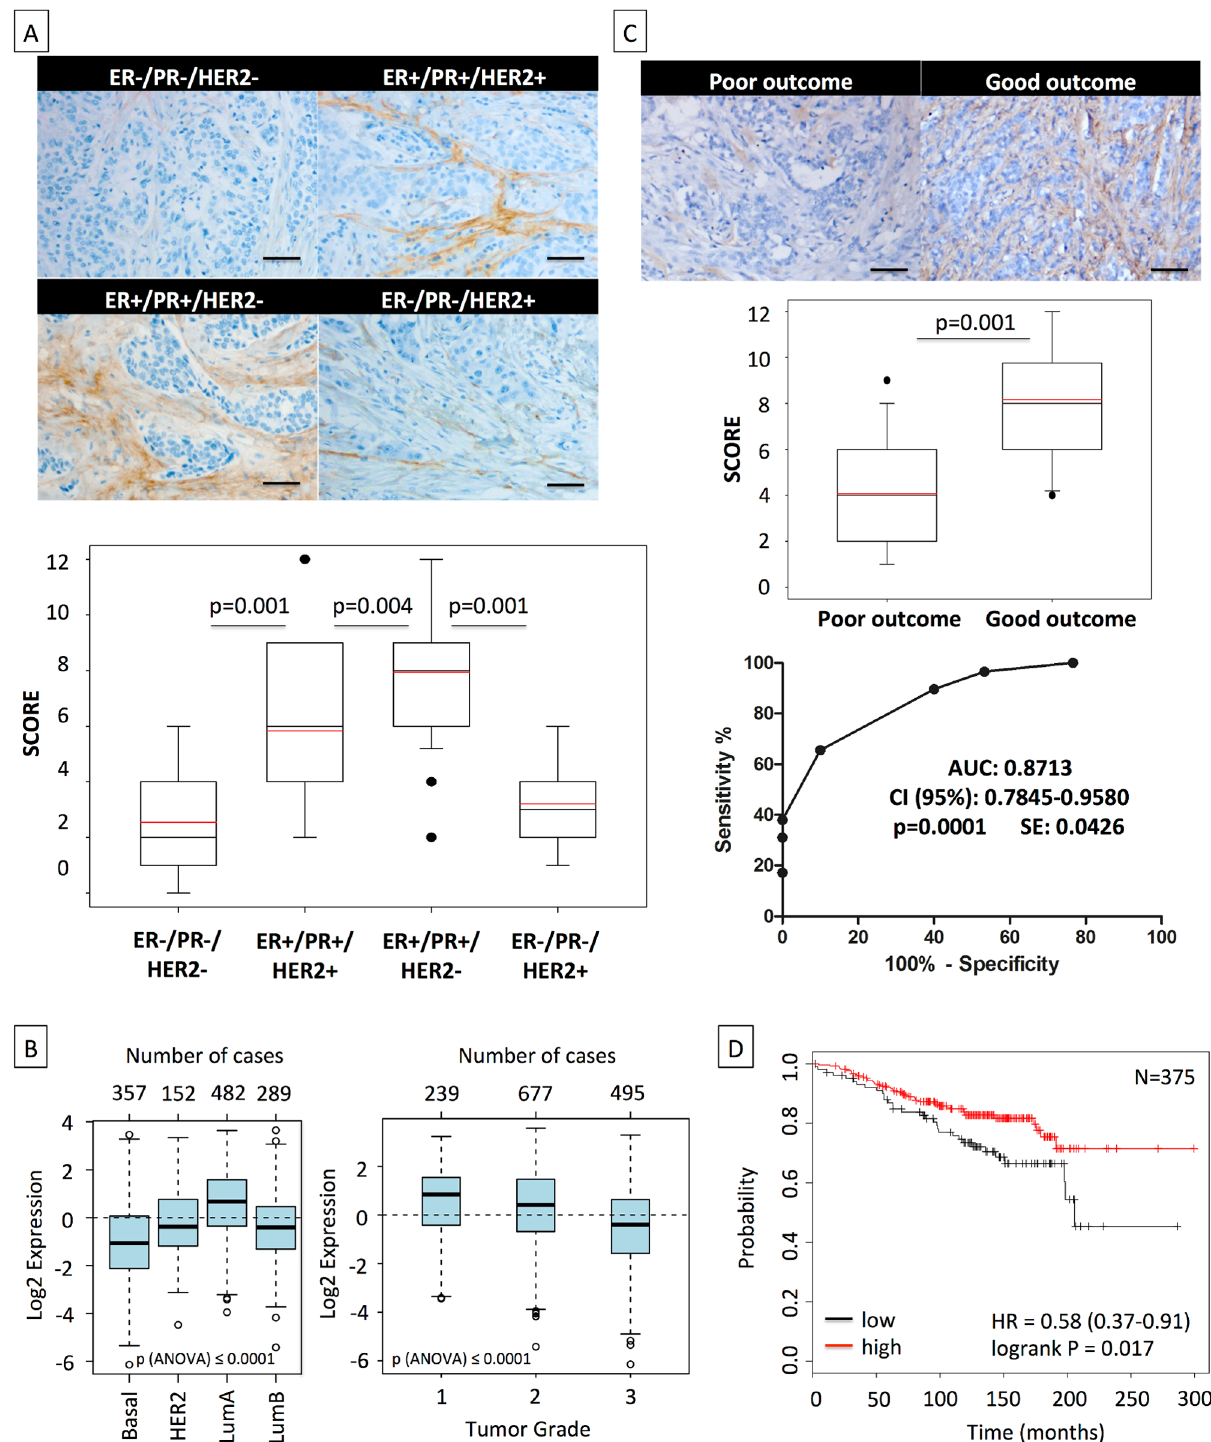
Fig 7. High asporin expression in human breast cancer matches with luminal-like tumor type and good patient outcome. (A) Representative IHC staining of asporin expression in human breast cancer tissues (upper panel). Box plots of asporin expression in 180 breast cancer patients with different status of HER2, ER, and PR are also shown (lower panel). The black line denotes the median expression, and the red line the mean expression. Significant differences in asporin expression were detected among all different subtypes of breast cancer. (B) Analysis of asporin mRNA expression in breast cancer tumors from different molecular subtypes ( n = 1,280) and evaluation of asporin mRNA expression in breast cancer of different pathological grades